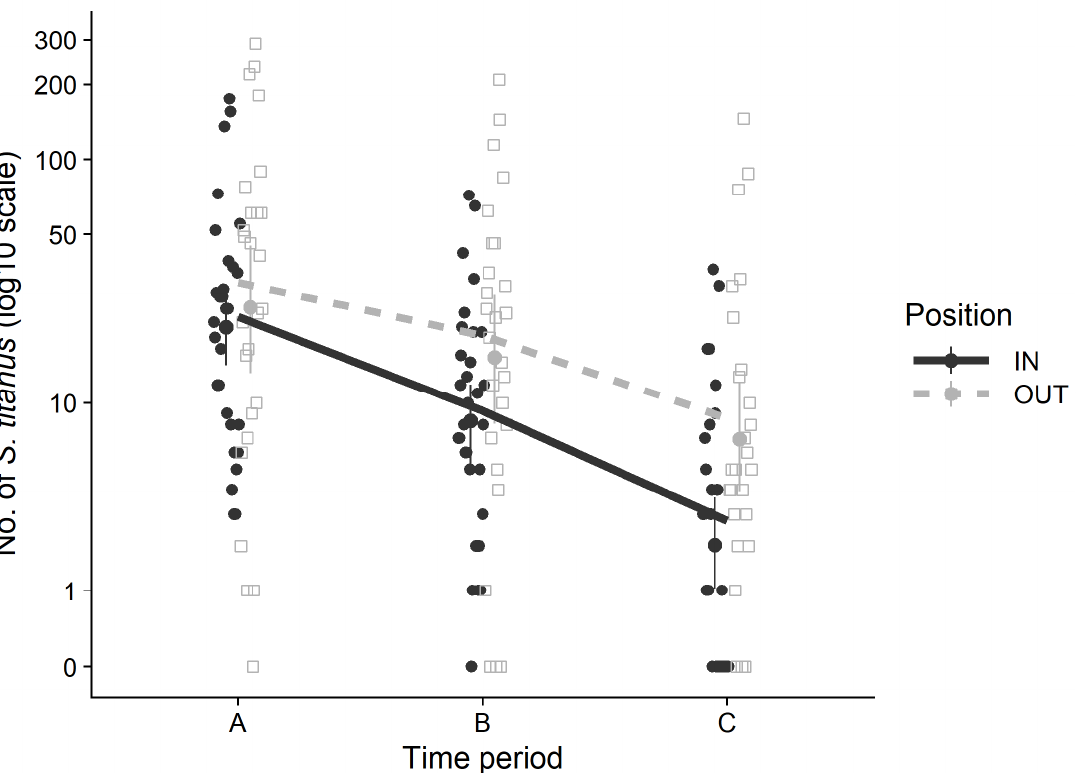
Figure 4. Number of S. titanus collected throughout the season in Piedmont vineyards. Black points and continuous line represent data and GLMM model of traps located inside the vineyard, whereas grey squares and grey dashed line represent data and model of traps located outside the vineyard.